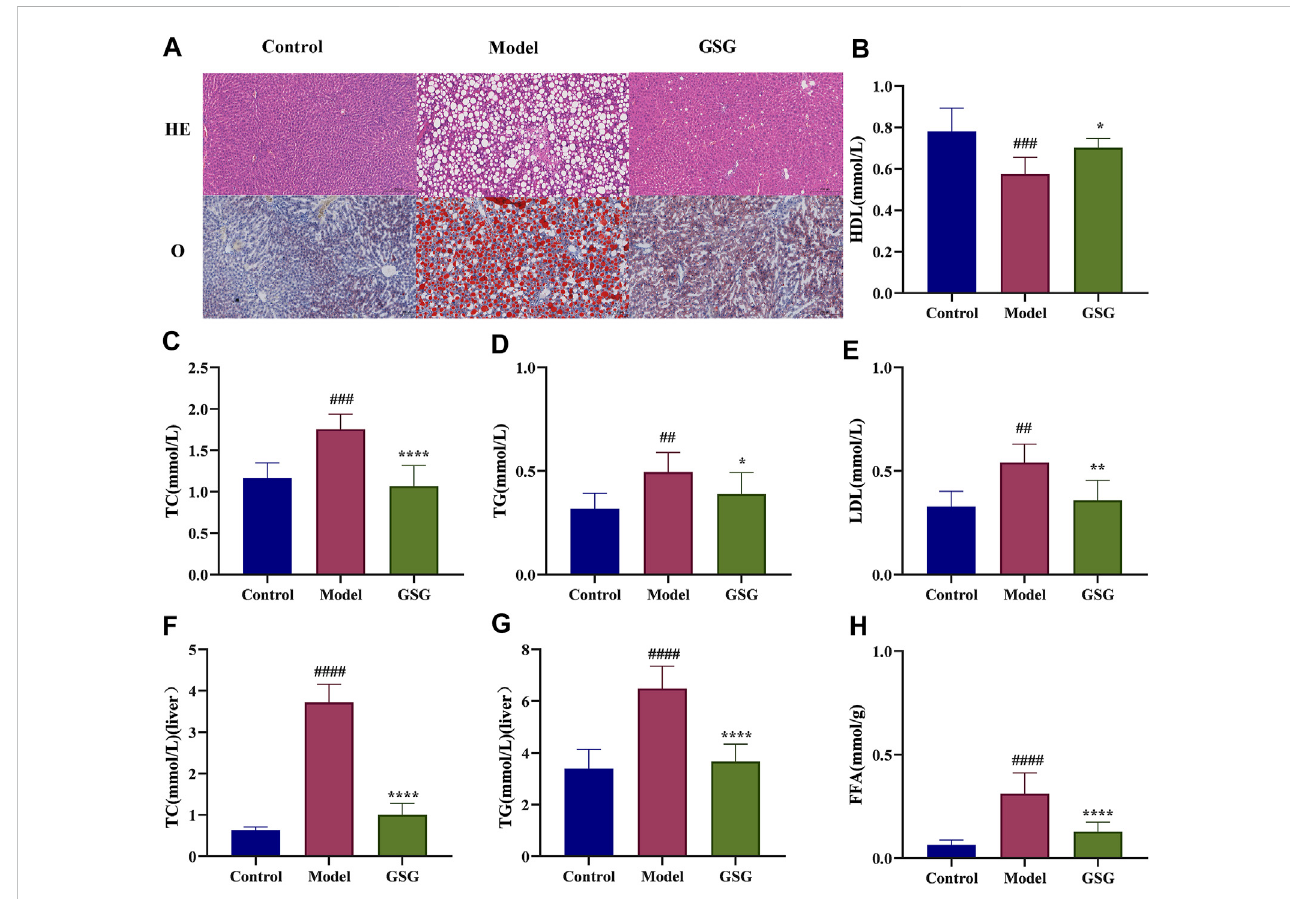
FIGURE 7 Regulation of lipidmetabolism byGSG. (A) OilredOstainingineachgroup. (B – E) Serumlevels ofHDL, TC, TG,and LDL ineachgroup. (F – H) Livertissue levels of TC, TG, and FFA in each group. Data are the mean ± S.E.M.; ## p < 0.01, #### p < 0.0001 vs. control; * p < 0.05, ** p < 0.01, **** p < 0.0001 vs. model; n =